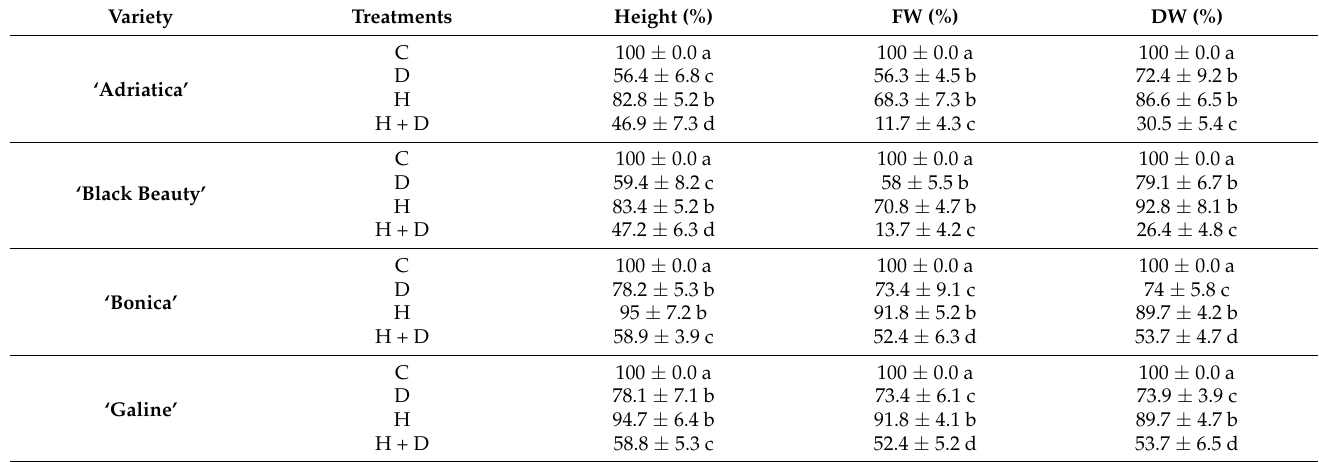
Table 1. Effect of drought, heat, and combined drought and heat on height (%) , fresh weight (FW) (%), and dry weight (DW) (%) of four eggplant cultivars. Results are expressed as percentage of control.